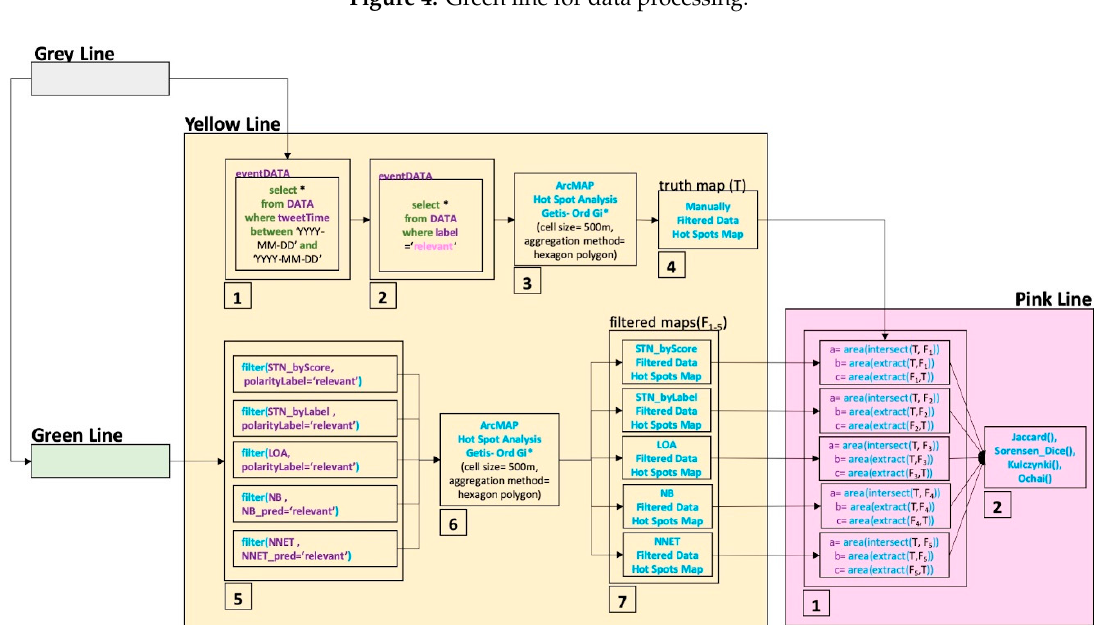
Figure 5. The yellow and pink lines. Figure 5. TheThe yellow line for hot spot mapping and the pink line for similarity calculation with current similarity